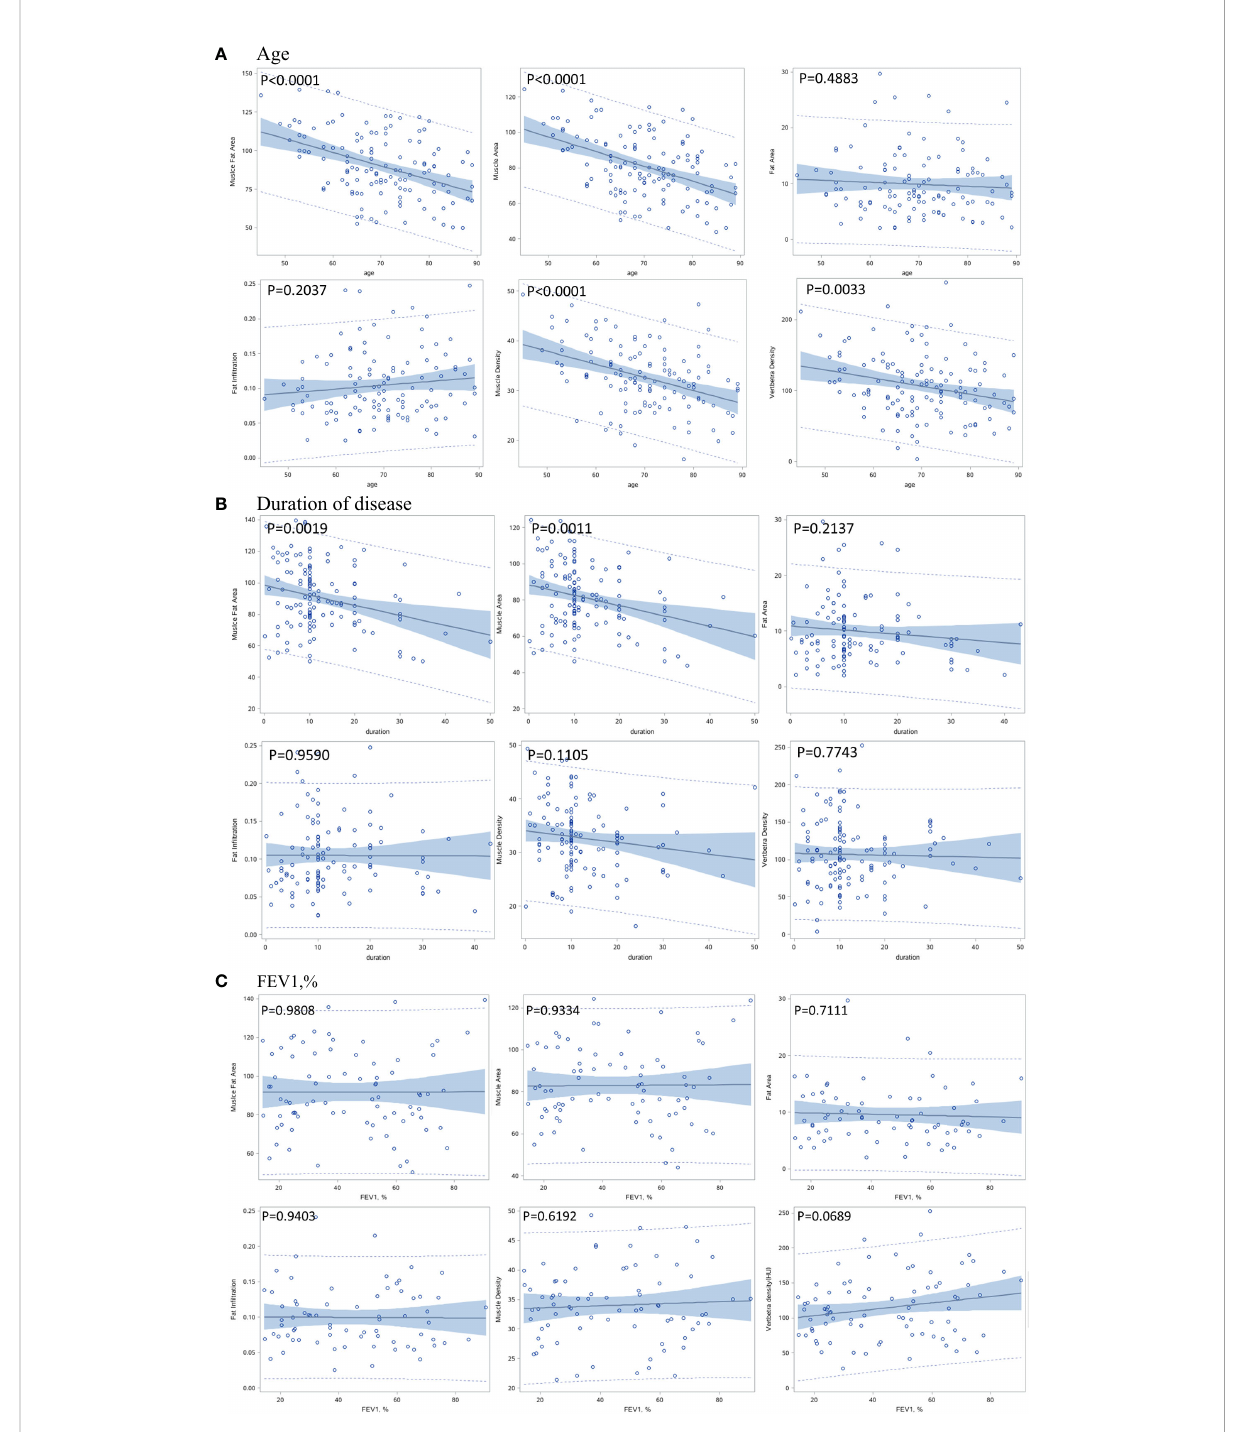
FIGURE 2 Correlation between baseline muscle and bone indexes with age (A) , duration of disease (B) , and pulmonary function (C)